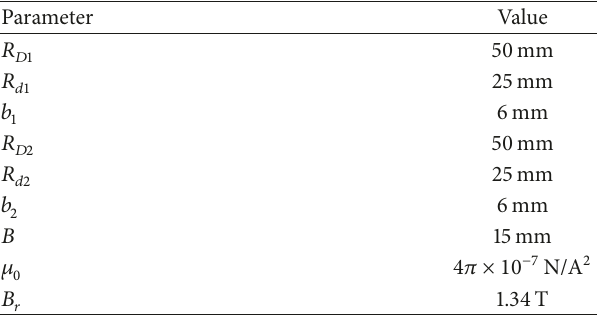
Table 1: Parameters for numerical simulation of magnetic force and stiffness.